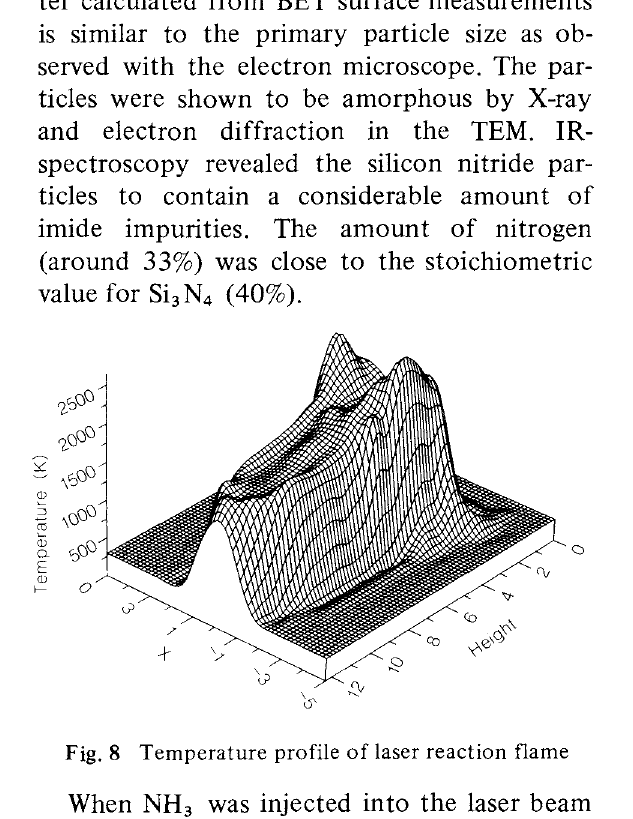
Fig. 8 Temperature profile of laser reaction